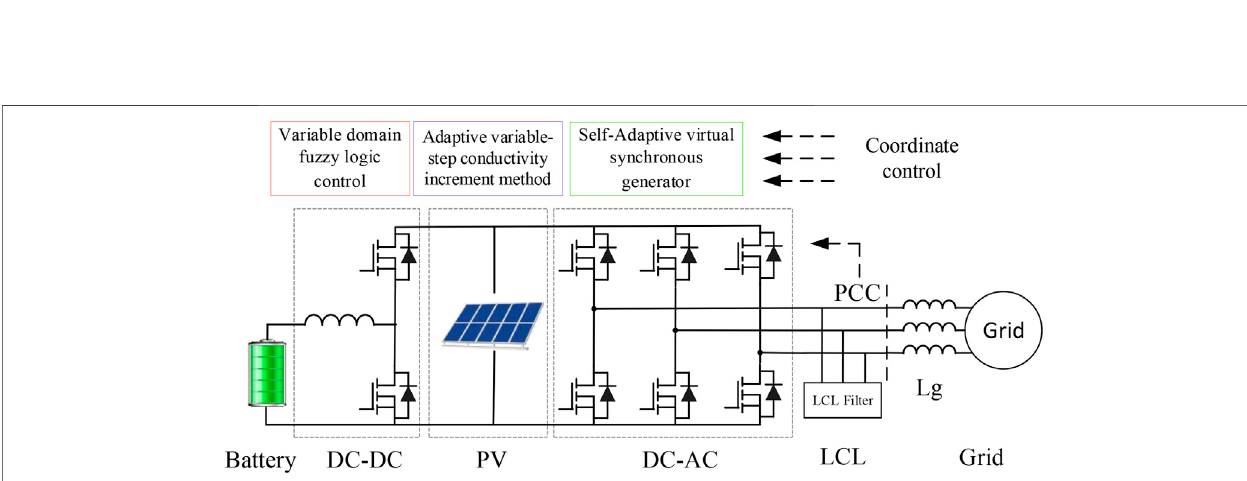
FIGURE 2 | Structure of grid-connected PV-energy storage